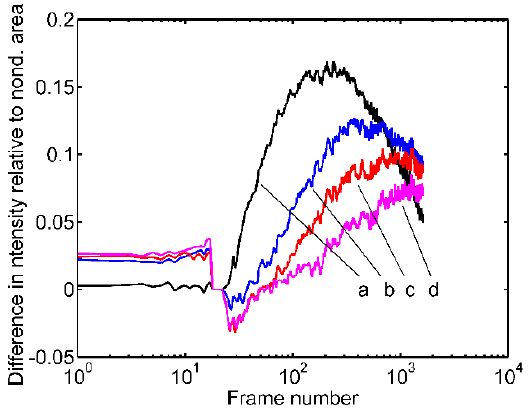
Figure 4. Deviation of values on curves B, C, D and E shown in Figure 3 from those of curve Sa: (a) B-Sa, (b) C-Sa, (c) D-Sa and (d) E-Sa.